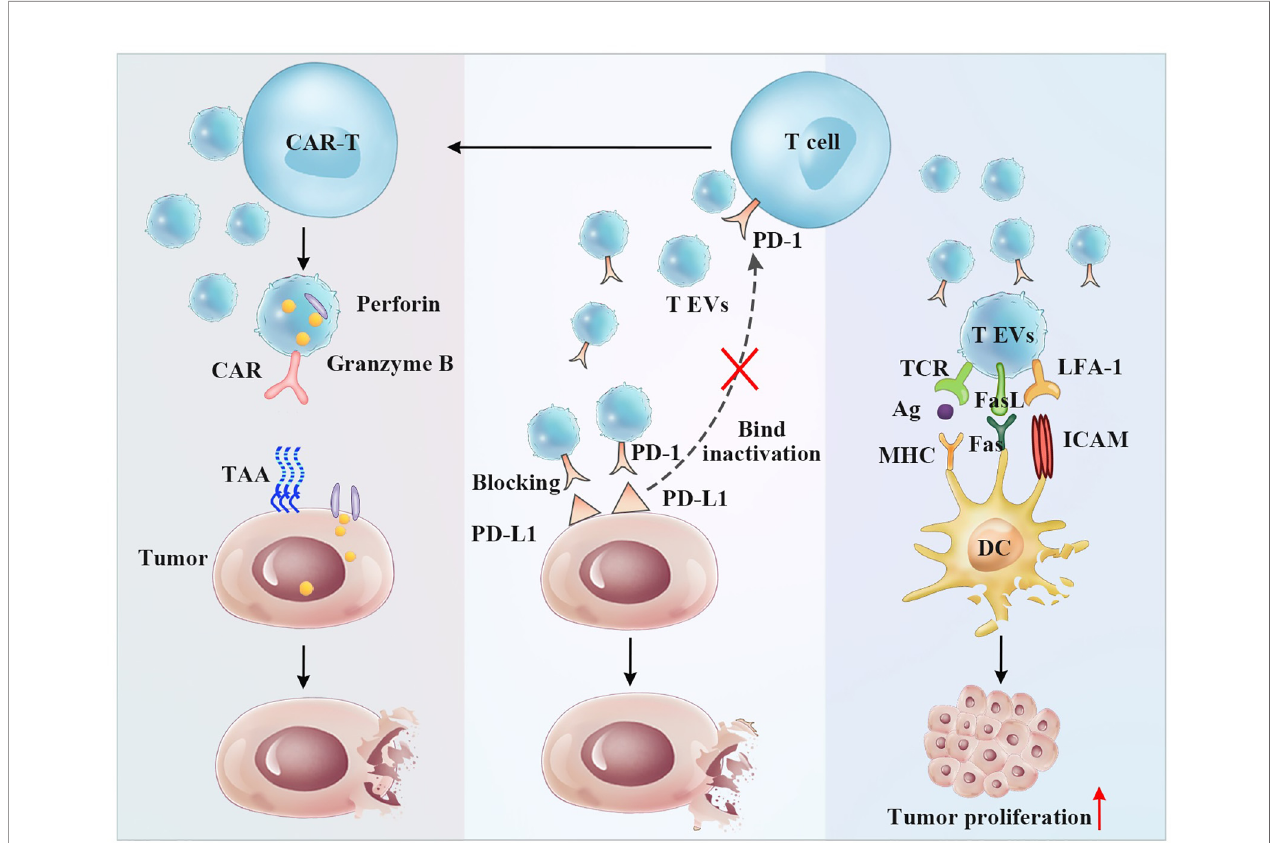
FIGURE 4 | The antitumor and immunoregulatory effects of T cell-derived EVs. Left panel: CAR-T cell EVs induce antitumor effect by CAR-targeted tumor cells and secreting perforin and granzyme B Middle panel: T EVs exposing the PD-1 receptor can bind PD-L1 expressing tumor cells preventing T cell inactivation. Right panel: T EVs exposing FasL receptor can bind Fas expressing DCs resulting DCs apoptosis and tumor